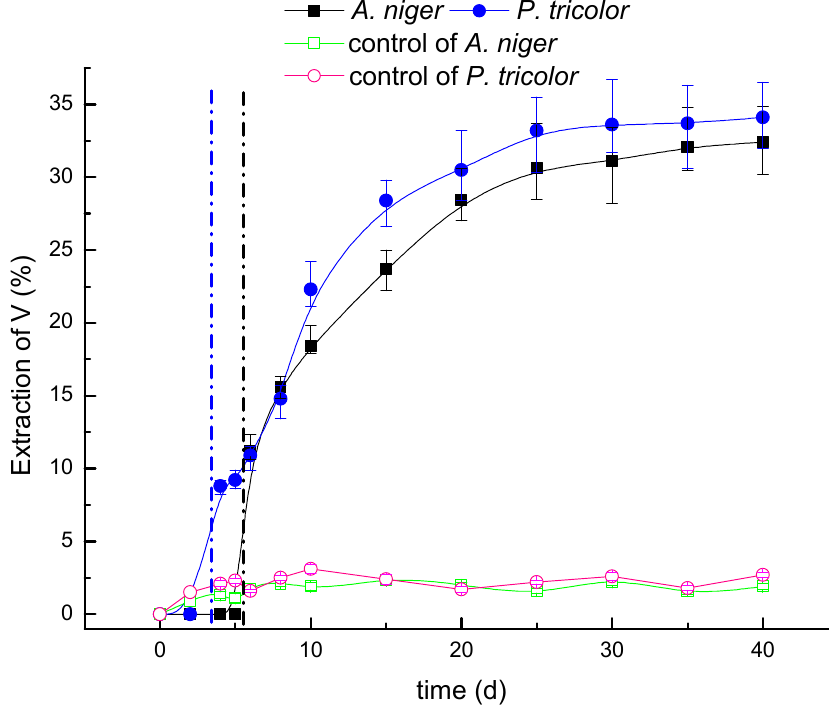
Figure 2. Variation of the leaching rate of V as a function of time using A. niger and P. tricolor under optimal leaching conditions (dashed and dotted lines represent the time when the pre-culture finished and RM was added into leaching system using A. niger (black) and P. tricolor (blue)).